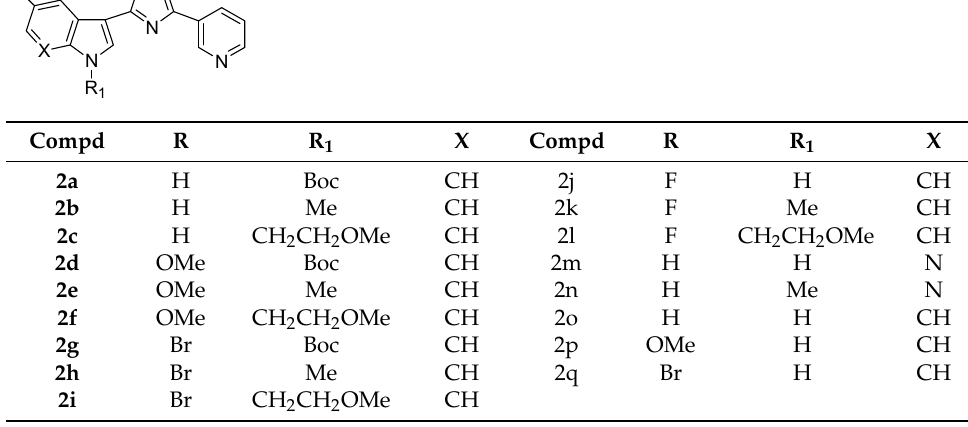
Table 2. Substituted 3-[4-(pyridin-3-yl)-1,3-thiazol-2-yl]-1 H -indole hydrobromides 2a–q .